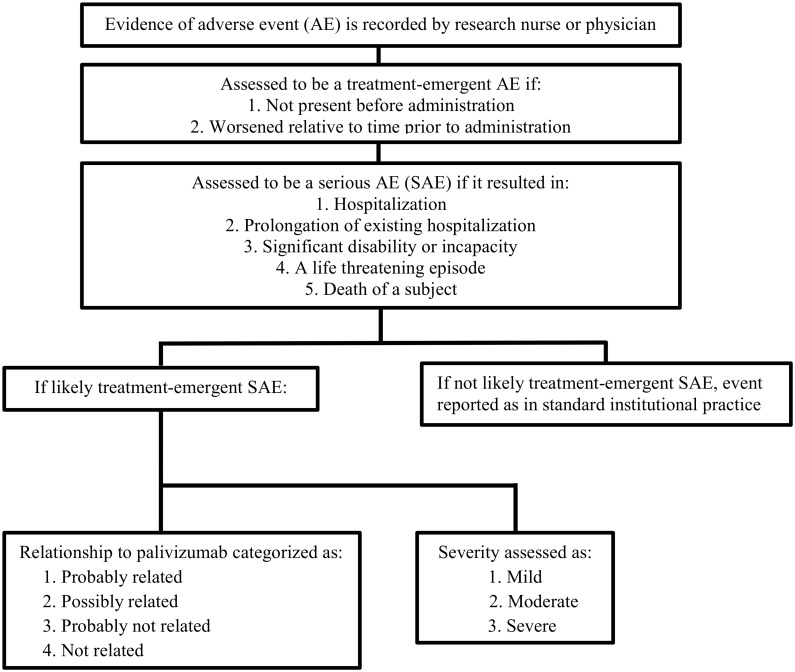
Flow diagram of the assessment of adverse events.